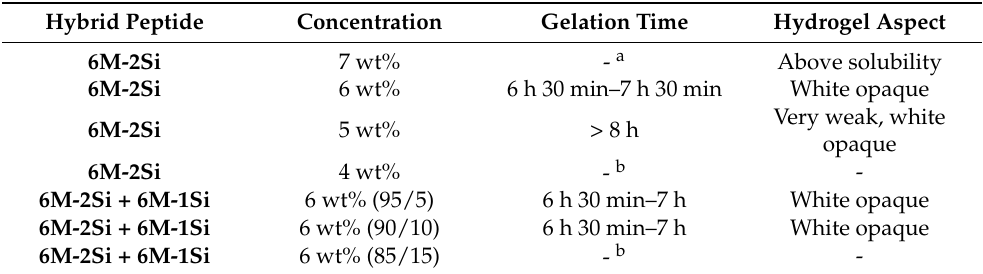
Table 1. Gelation time and the aspect of hydrogels with 0.1 mg/mL NaF and 10 mg/mL glycine at 37 ◦ C in DPBS pH 7.4.